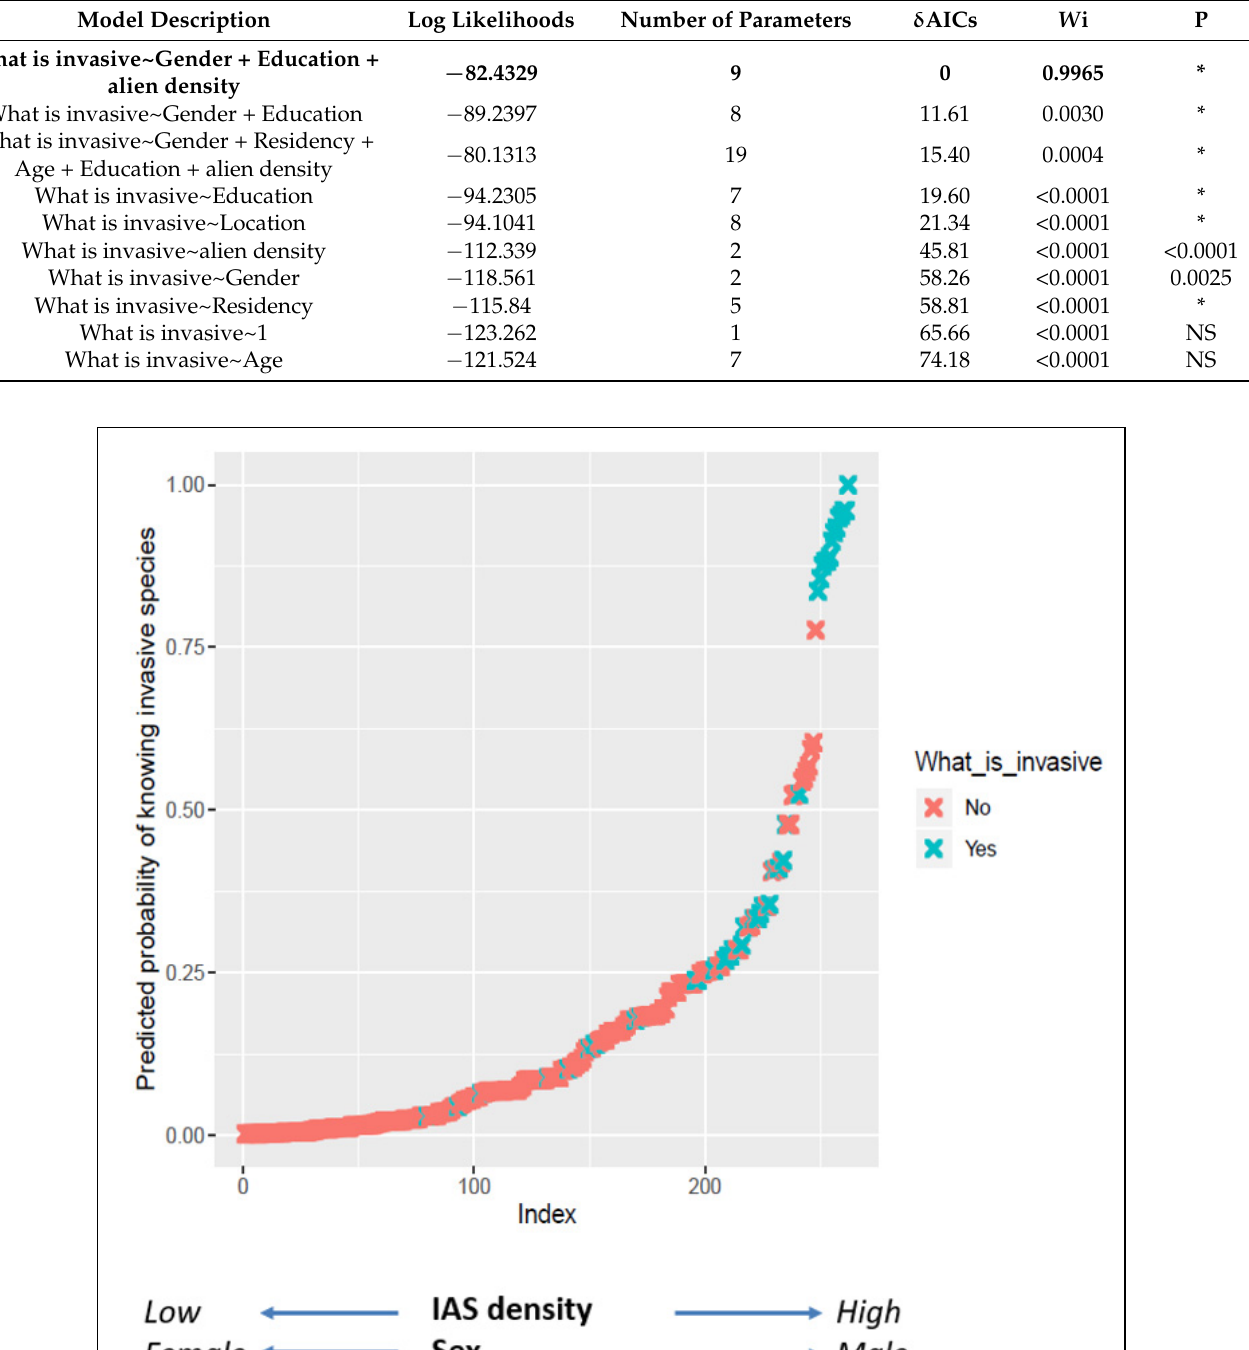
Table 1. Candidate models explaining demographic covariates and species density (continuous independent variable). The models are ordered by their relative AIC, and the best model is highlighted in bold. W i (Akaike weight) is the relative support a model had from the data compared to the other models in the set. Significance levels (P) for models with categorical variables (*) are reported in Supplementary Material S6 (NS: not significant).